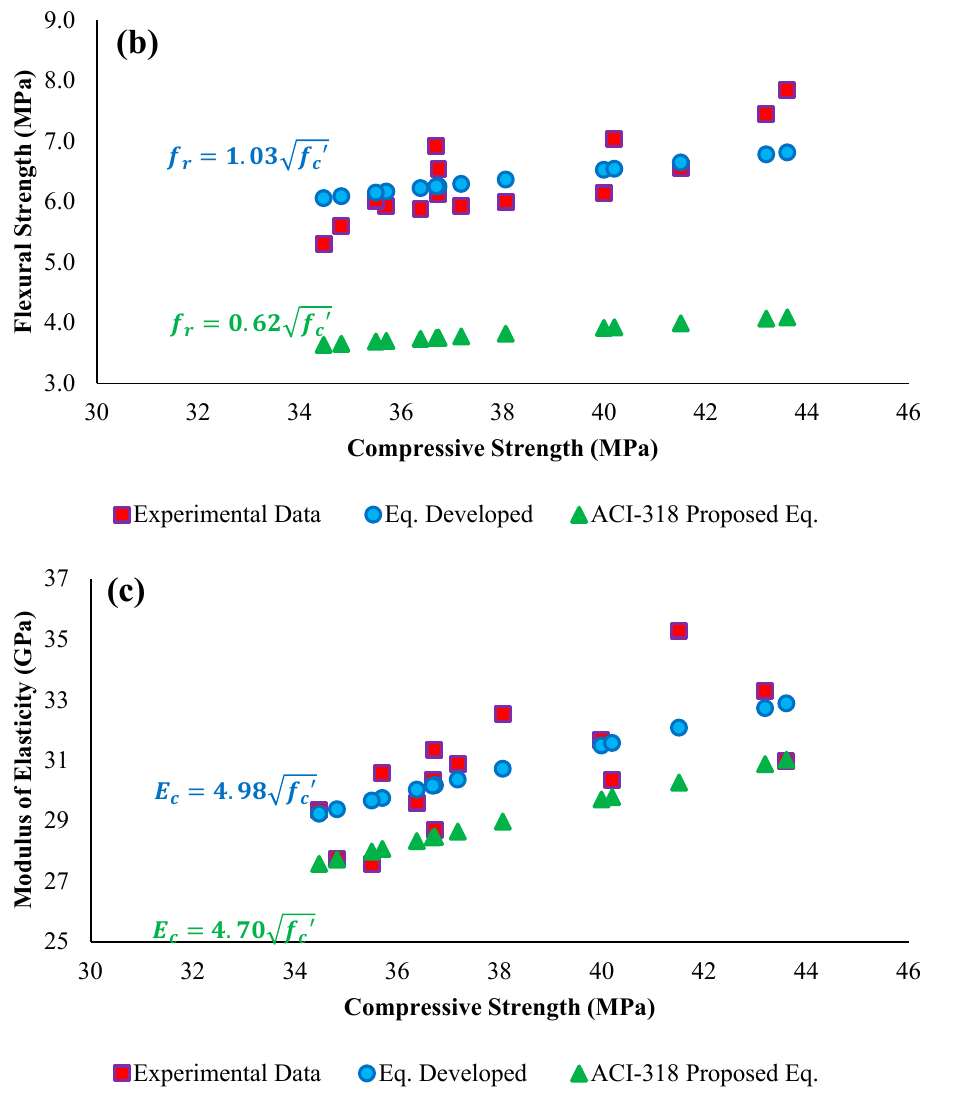
Figure 16. Comparison of experimental data with ACI proposed models and developed equations between ( a ) compressive strength and tensile strength; ( b ) compressive strength and flexural strength; ( c ) compressive strength and modulus of elasticity.